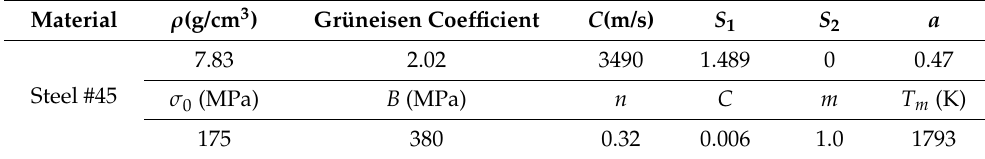
Table 6. Material parameters of steel #45 for